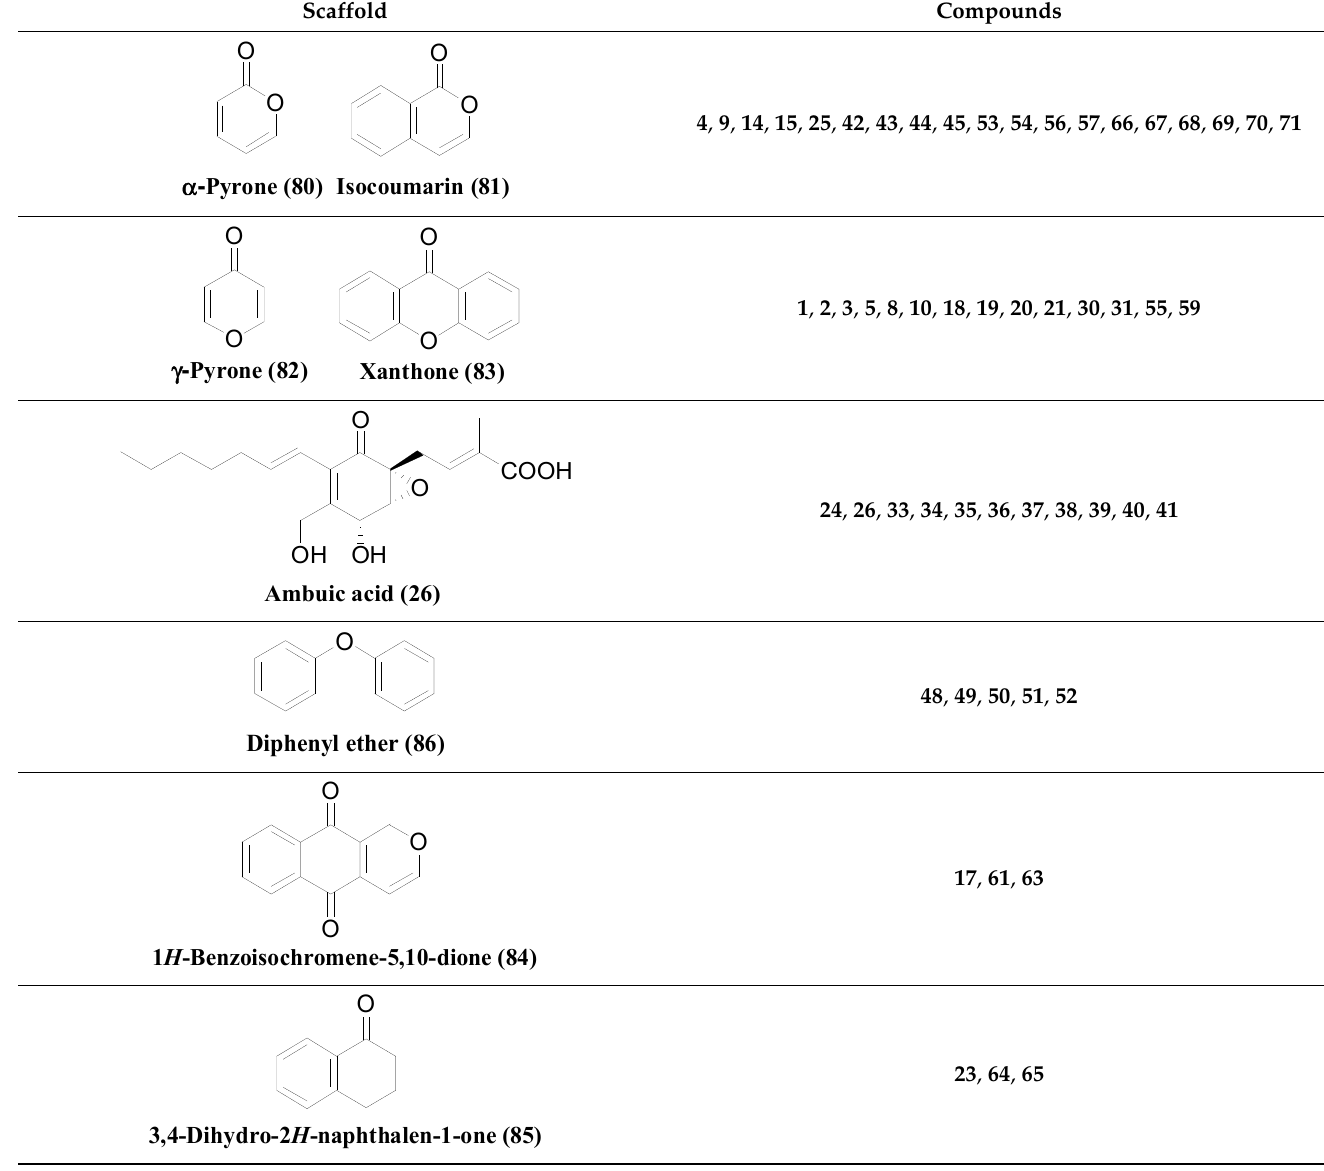
Figure 1. Structures of the antimicrobial compounds isolated from ELF.